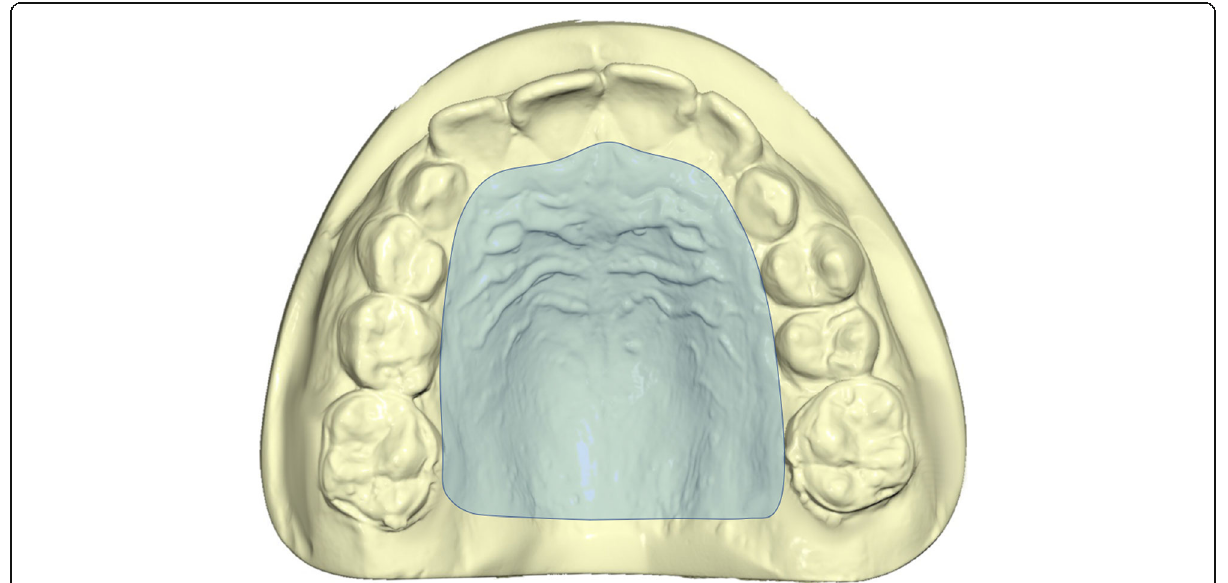
Fig. 3 Graphic description of palatal area measurement, comprised within the crossing point between lingual groove and gingival border of both deciduous and permanent upper incisors, canines, premolars, and molars Table 8 showed the discriminant analysis results. The